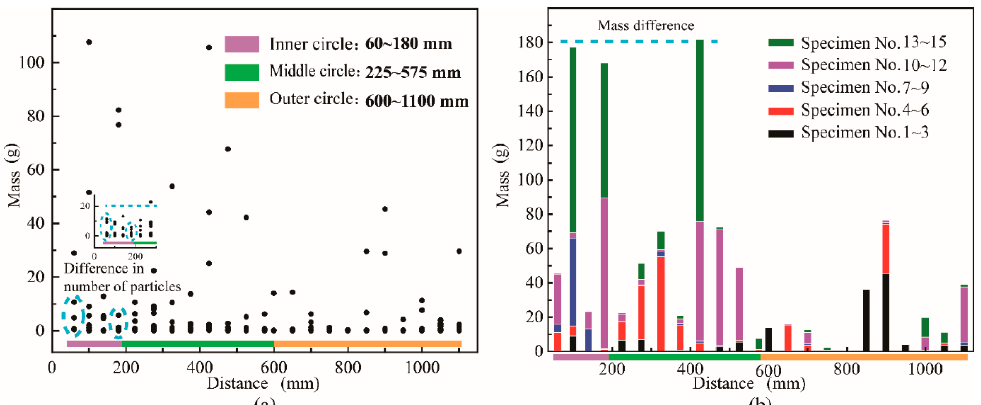
Figure 13. Spatial distribution characteristics of surface particles. ( a ) Scatter plot of particle spatial distribution ( b ) Summary of particle spatial distribution of each group